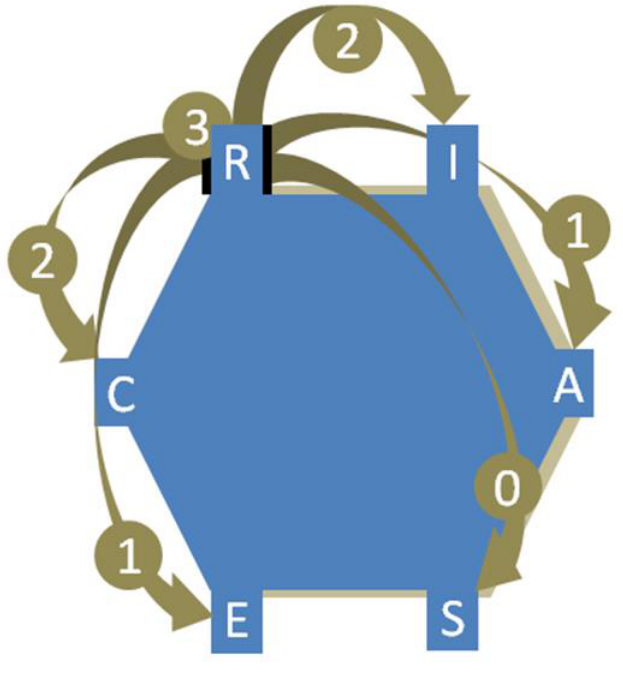
Figure 2. RIASEC hexagonal model and levels of congruence for the Realistic dimension. After achieving the congruence score, participants were divided into two halves, based on the median value. We took this decision because we identified a non-normal distribution. The value 11, corresponding to the median, was used as a parameter so that equal or lower values were classified as “ lower congruence ” , and higher values classified as “ higher congruence ” .